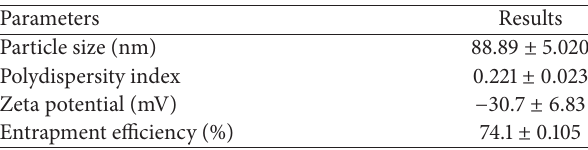
Table 1: Results of optimized LCDP loaded NLC